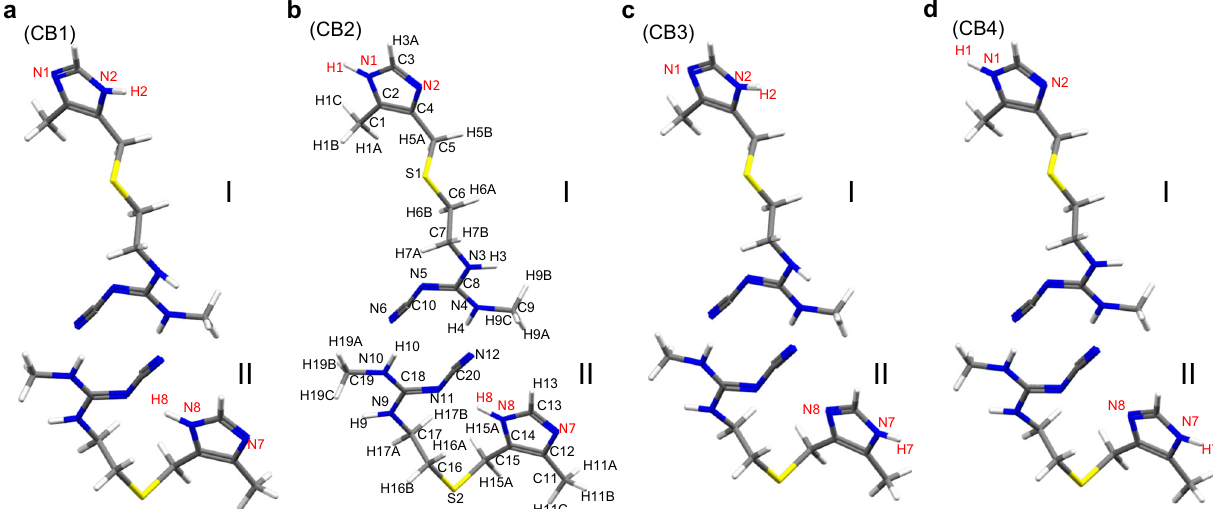
Fig. 5 Four possible molecular structures of cimetidine form B. The cimetidine form B (CB) structures of a CB1, b CB2, c CB3, and d CB4 depend on the protonation site of the imidazole ring. The atomic numbering scheme is shown. Each structure is composed of two conformations; I and II refers to an extended and a bent conformation, respectively. The yellow, blue, gray, and white atoms denote sulfur, nitrogen, carbon, and hydrogen atoms,